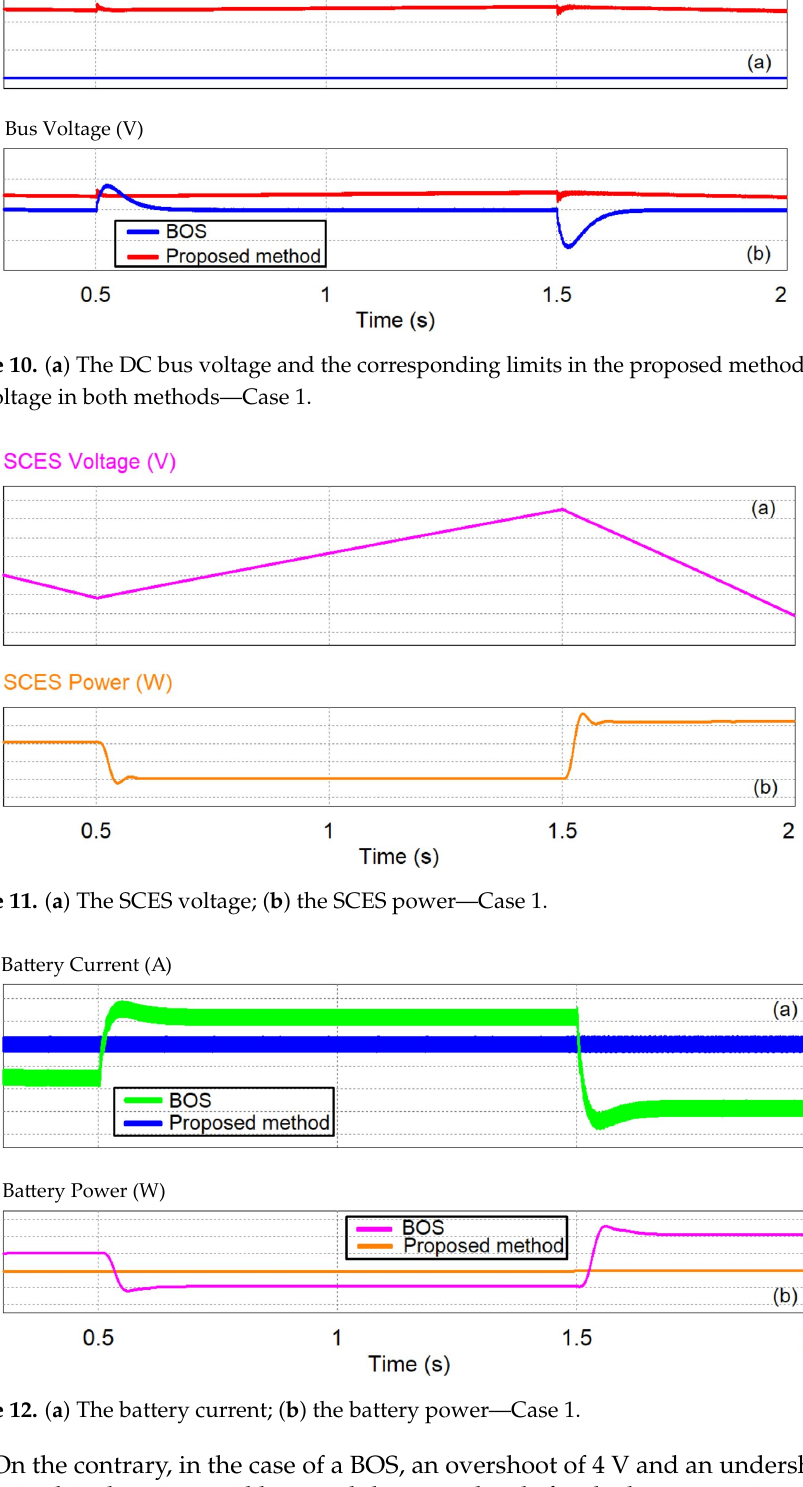
Figure 9. The power of PV, WTG, and load—Case 1.